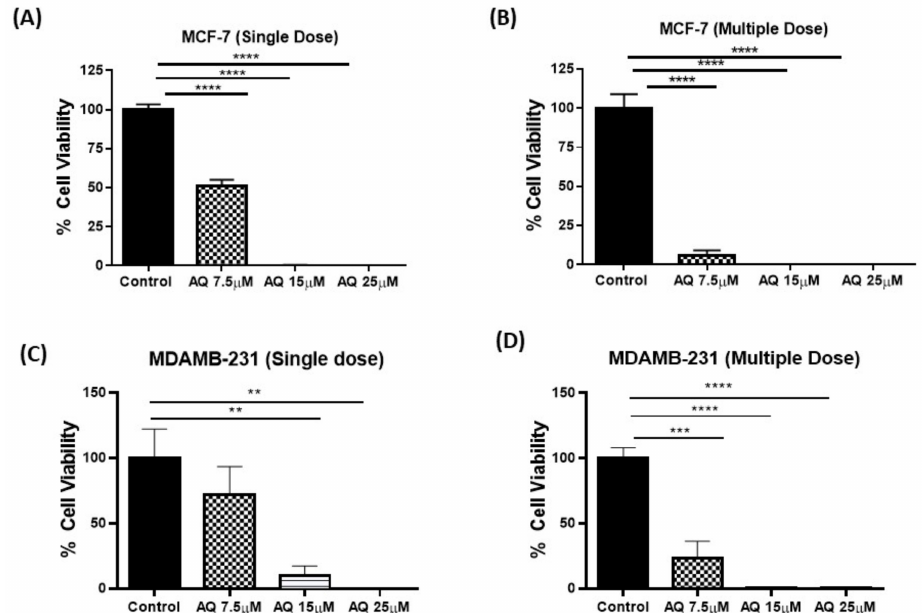
Figure 6. ( A , B ) Cell viability study on MCF-7 Spheroids. ( C , D ) Cell viability study on MDAMB- 231 Spheroids. The results indicate % cell viability after each treatment, comparisons were made by considering control as 100%. Data represent mean ± SD ( n = 3). ** p < 0.01, *** p < 0.001, **** p <